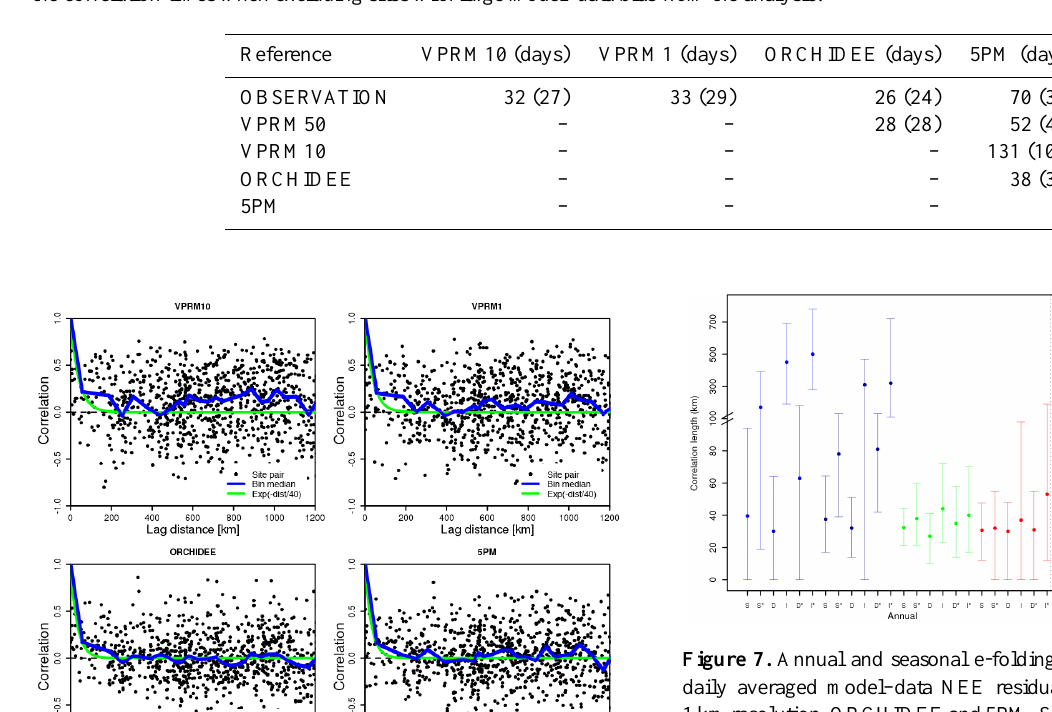
Table 2. Annual temporal autocorrelation times in days, from model–data and model–model residuals. The number within the brackets shows the correlation times when excluding sites with large model–data bias from the analysis.